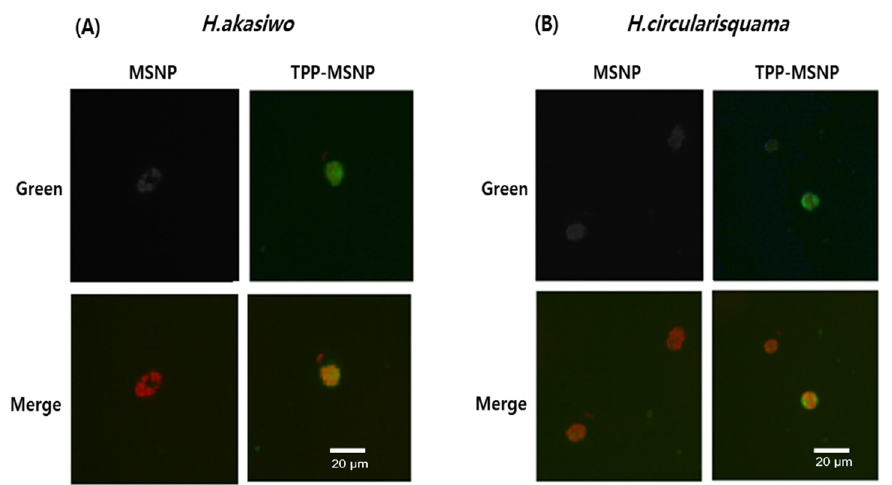
Figure 3. Fluorescence images of coumarin-6 labeled MSNP or TPP-MSNP on ( A ) H. akashiwo, ( B ) H. circularisquama.